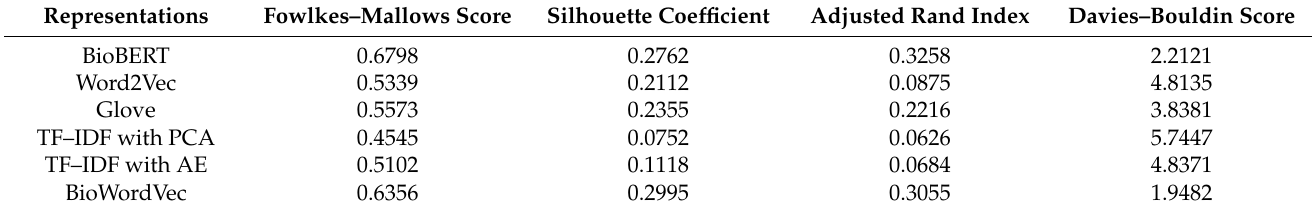
Table 5. Evaluation results of expectation–maximization clustering for biomedical